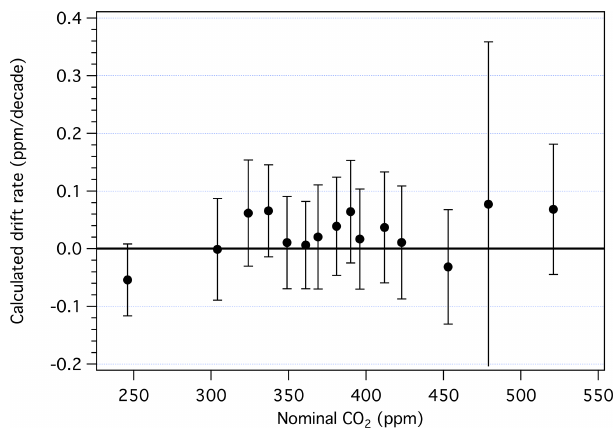
Figure 8. Drift rates (ppm per decade) determined from 5 to 10 manometric episodes. Error bars are 95% confidence